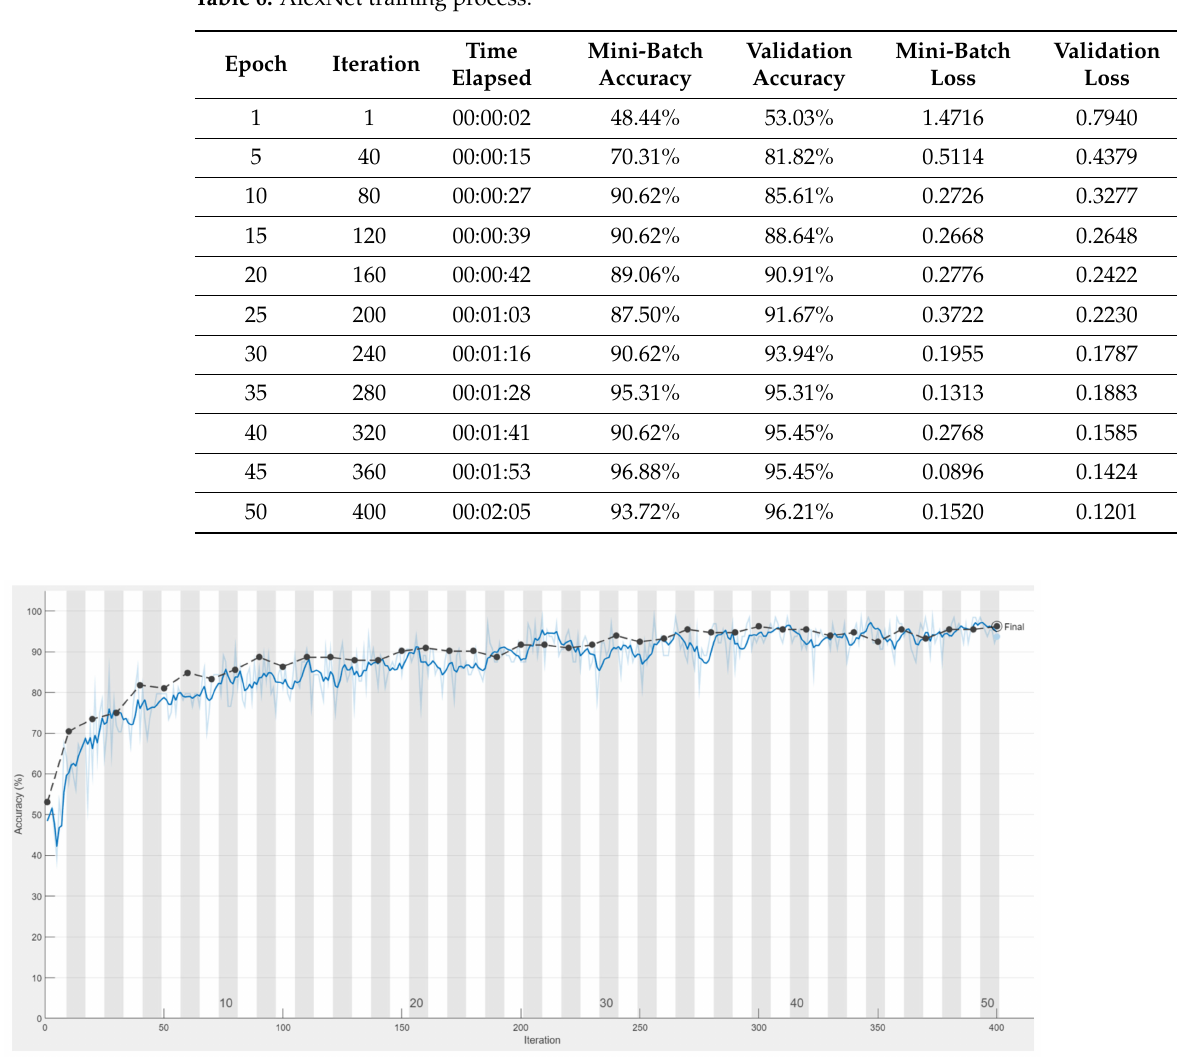
Figure 10. The accuracy of Alexnet model in test set which is black line and training set which is blue line during training process.